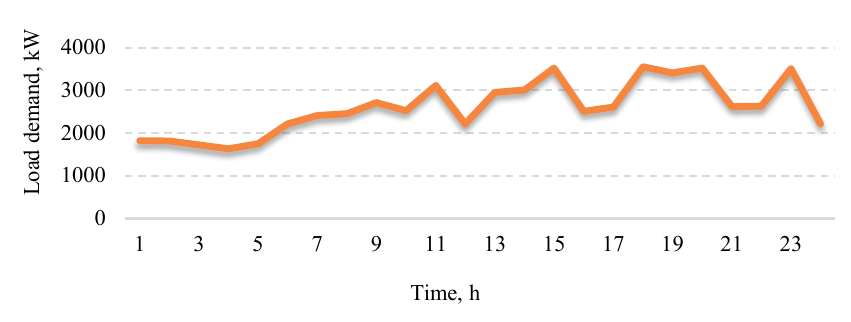
Fig. 4. Load demand of